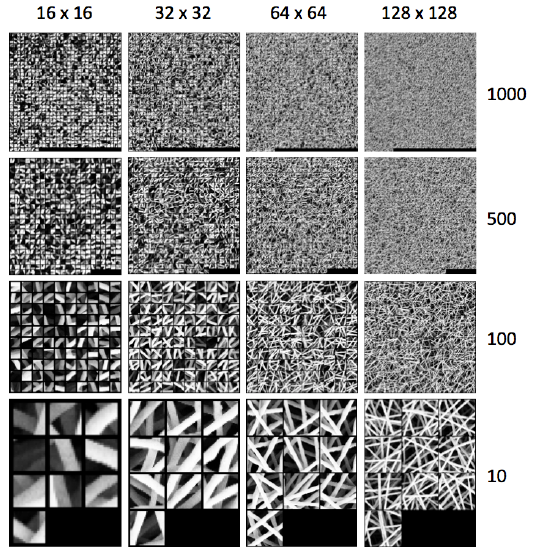
Figure 5. Examples of images corresponding to the features from the dictionary. Here, we show different dictionaries built with different patch sizes (16, 32, 64, 128) and number of clusters (10, 100, 500,